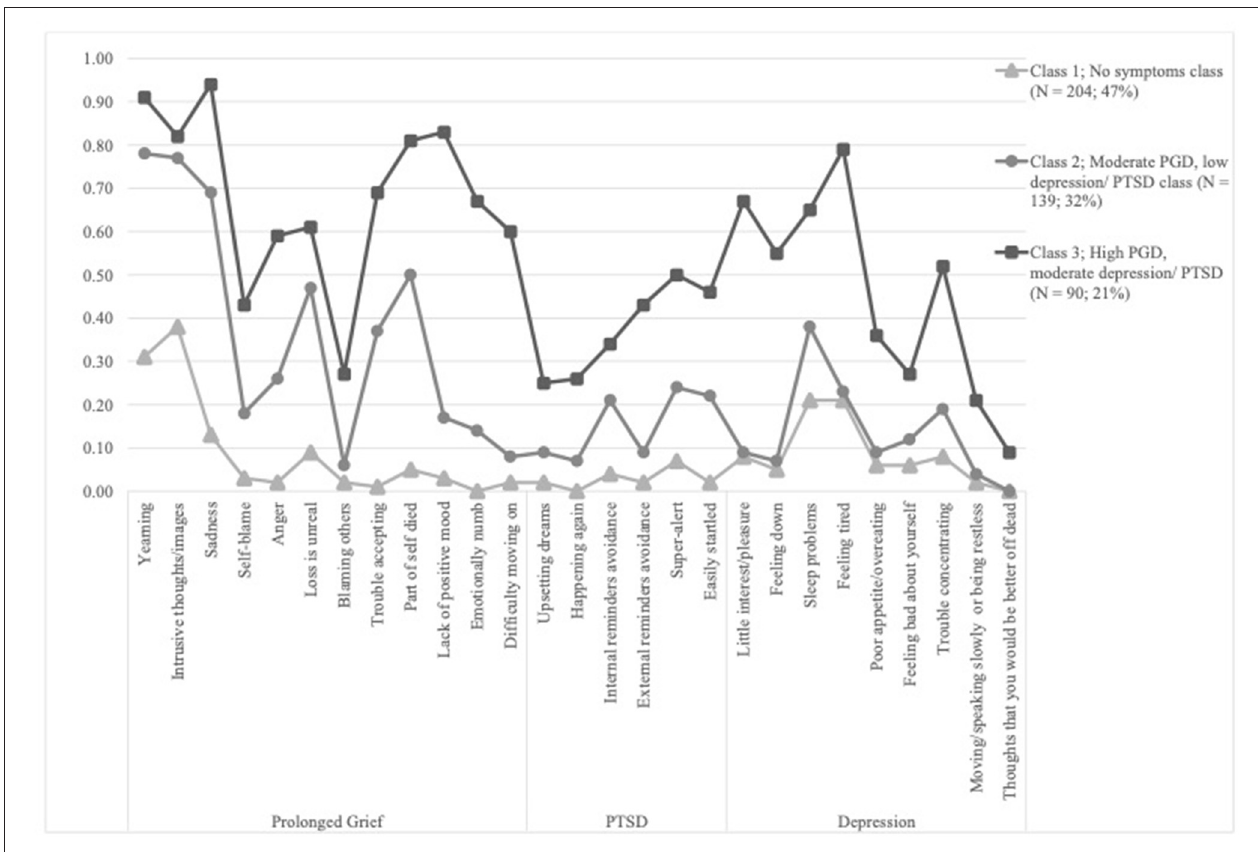
FIGURE 1 | Probability estimates of the three class solution ( N = 433).